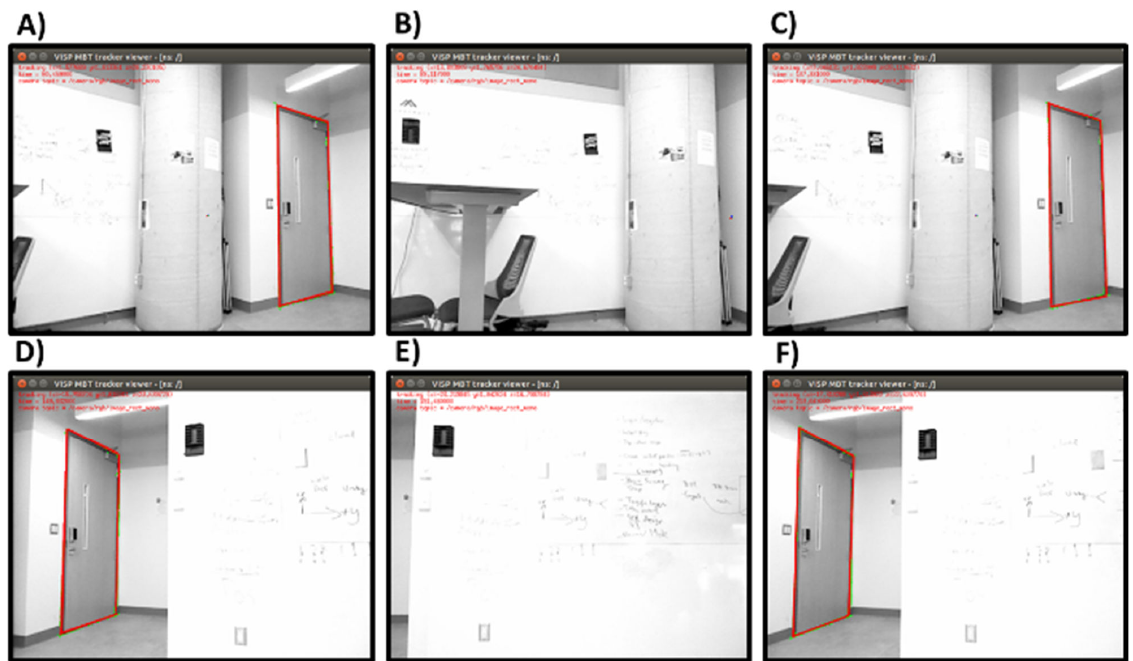
Figure 10. Sample frames from the first experiment demonstrating ViSP’s model-based tracker aided by RGB-D SLAM. The door of York University’s BEST lab leaves the field of view in B) and E). The door re-enters the field of view in Frames C) and F), showing that tracking the pose was not lost.